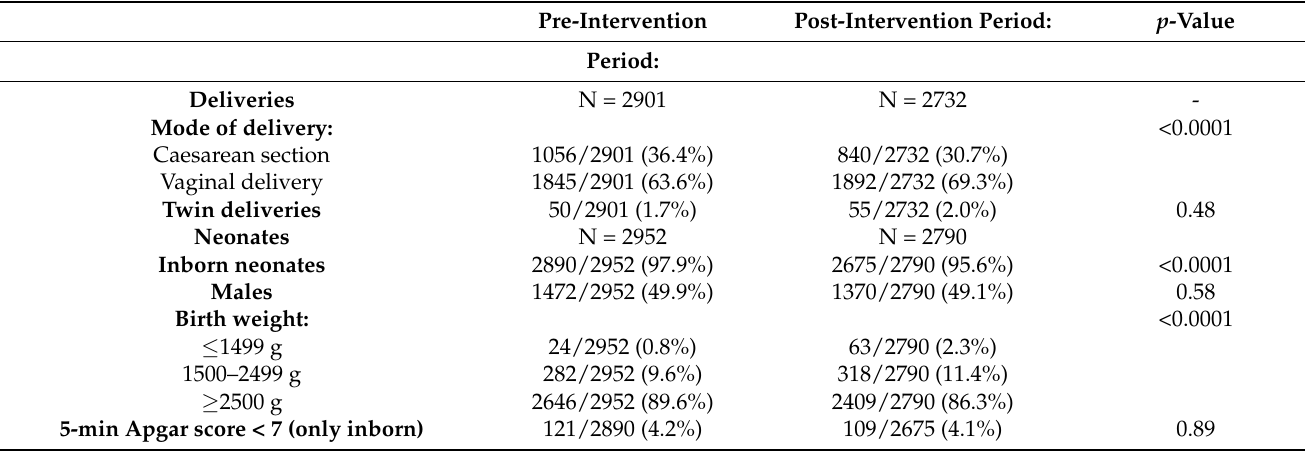
Table 2. Baseline characteristics of neonates admitted to the SCU in the pre- vs. post-intervention